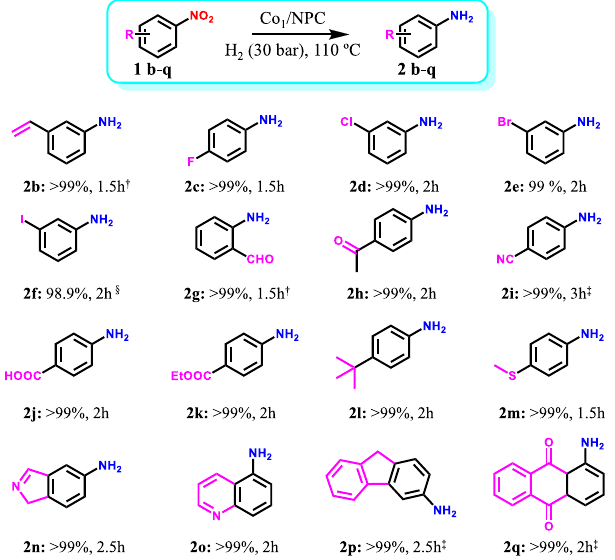
Fig. 6 Substrate scope of hydrogenation over the Co 1 /NPC